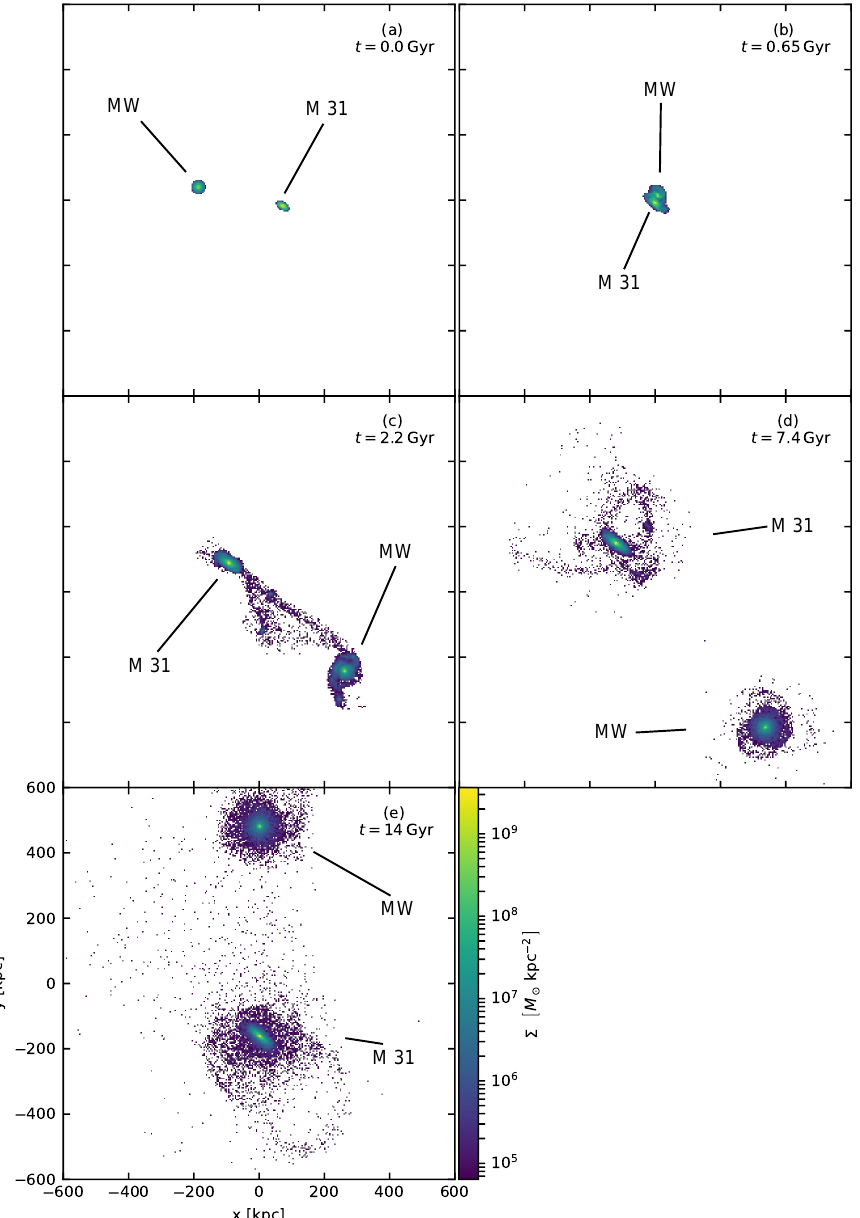
Figure 1. Snapshots from the simulations. ( a ) Simulation starts. ( b ) Galaxies are in the first pericenter. ( c ) Transmission of material from the simulated Milky Way to Andromeda. ( d ) Time when the observed separation and relative velocities of the galaxies are reproduced, i.e., the current time. ( e ) Simulation ends. Credit: Bílek et al., A&A, 614, A59, 2018, reproduced with permission ©ESO. The tidal arms captured by the simulated Milky Way formed a flattened feature too. Its size corresponded roughly to the disk of the Milky Way. The particles, when projected on the sky at the position of the Sun in the simulation, formed streams with coherent motions. This resembled the observed phase-space correlation of the satellites of the Milky